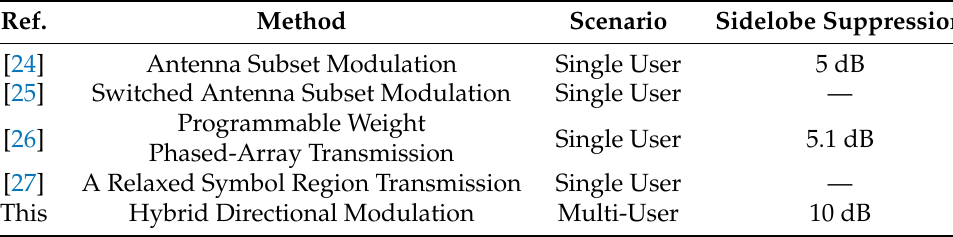
Table 1. The comparison of physical layer modulation technology.